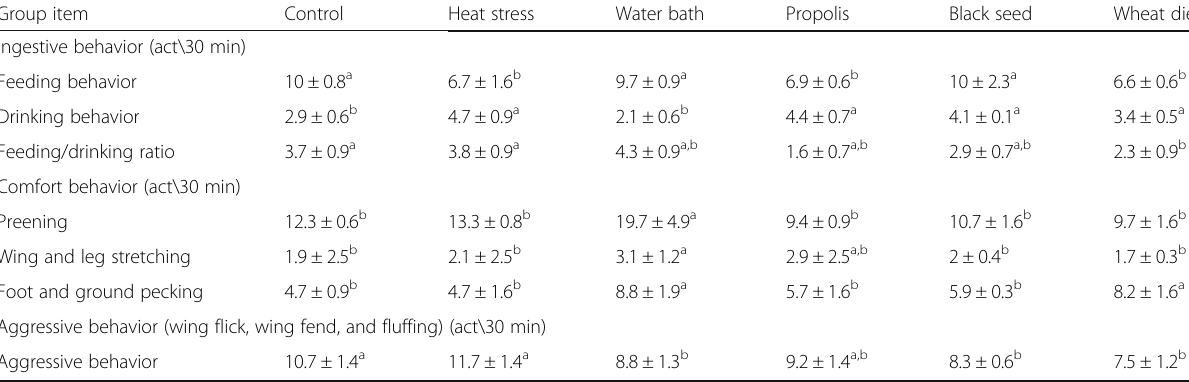
Table 3 Managerial and nutritional effect on ingestive, comfort, and aggressive behavior of heat-stressed pigeon Group